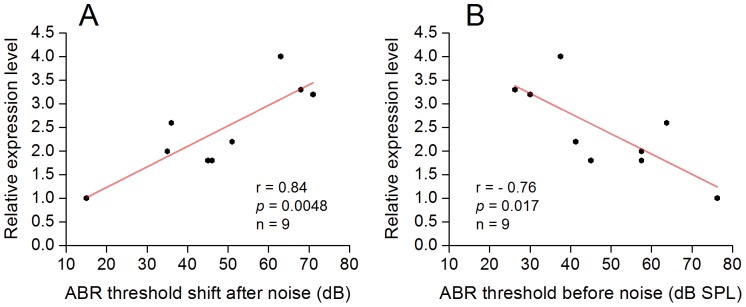
The Prestin-CreERT2 knockin homozygous mice display a strong correlation between the levels of Cdh1 expression and the levels of noise-induced threshold shifts.
Cdh1 expression in the organ of Corti tissues was examined using qRT-PCR. The expression levels are normalized to three reference genes (Actin, GAPDH and Hprt1) and are presented as the fold difference between the prestin expression level and the reference gene expression level. A Pearson's correlation analysis reveals a significant positive correlation between the expression level of Cdh1 and the threshold shifts examined at 2 h after the acoustic injury (Pearson correlation analysis, r = 0.84, p = 0.0048). B Pearson's correlation analysis shows a significant negative correlation between the expression levels of Cdh1 and the levels of pre-noise ABR thresholds (Fig. 7B; r = −0.76, p = 0.0172). This result suggests that a greater auditory dysfunction caused by Prestin-CreERT2 knockin leads to a lower cdh1 response to acoustic overstimulation. n =  the number of ears used for the analysis.